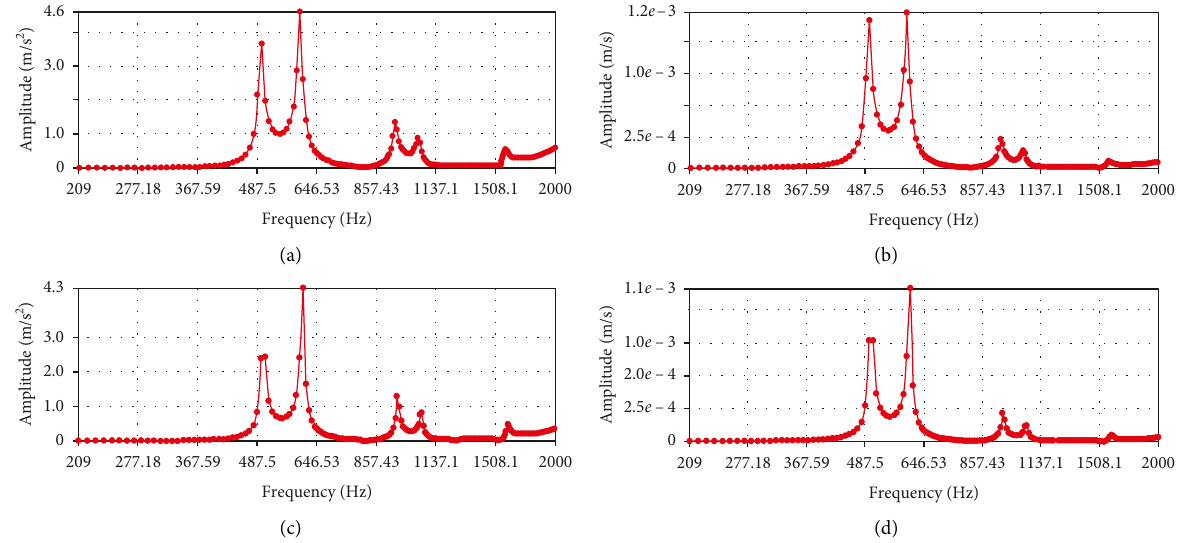
Figure 9: The results of simulations. (a) Magnesium alloy a . (b) Magnesium alloy v . (c) Aluminum alloy a . (d) Aluminum alloy v .